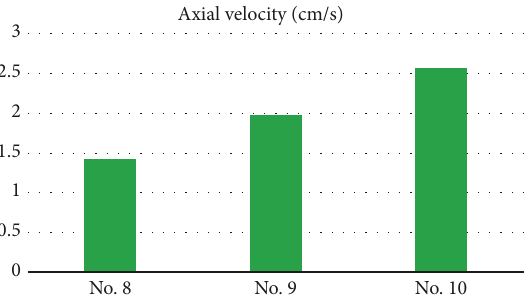
Figure 11: Amplification effect for blasting vibration in 6# set.